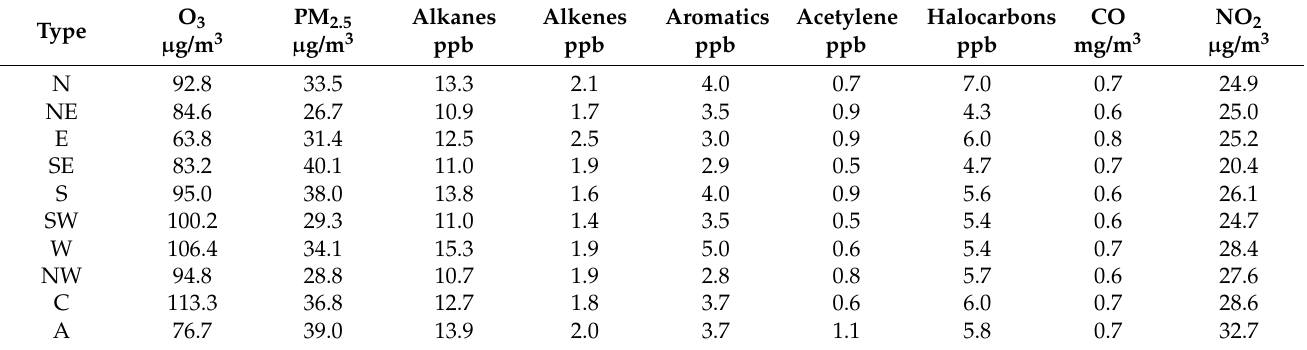
Table 2. The average concentration of pollutants with the influence of different circulation